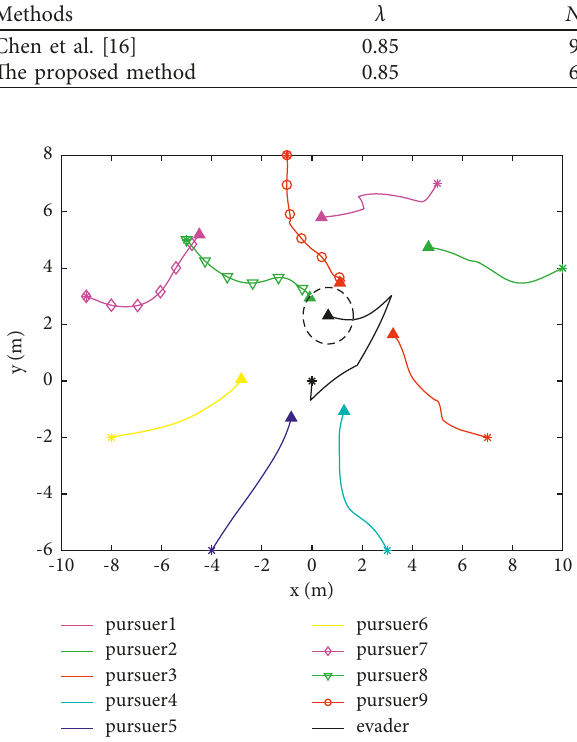
Figure 8: Trajectories of the players with cooperative hunting strategy ( N � 9, λ � 0 . 75). The pursuer 8 captures the evader.